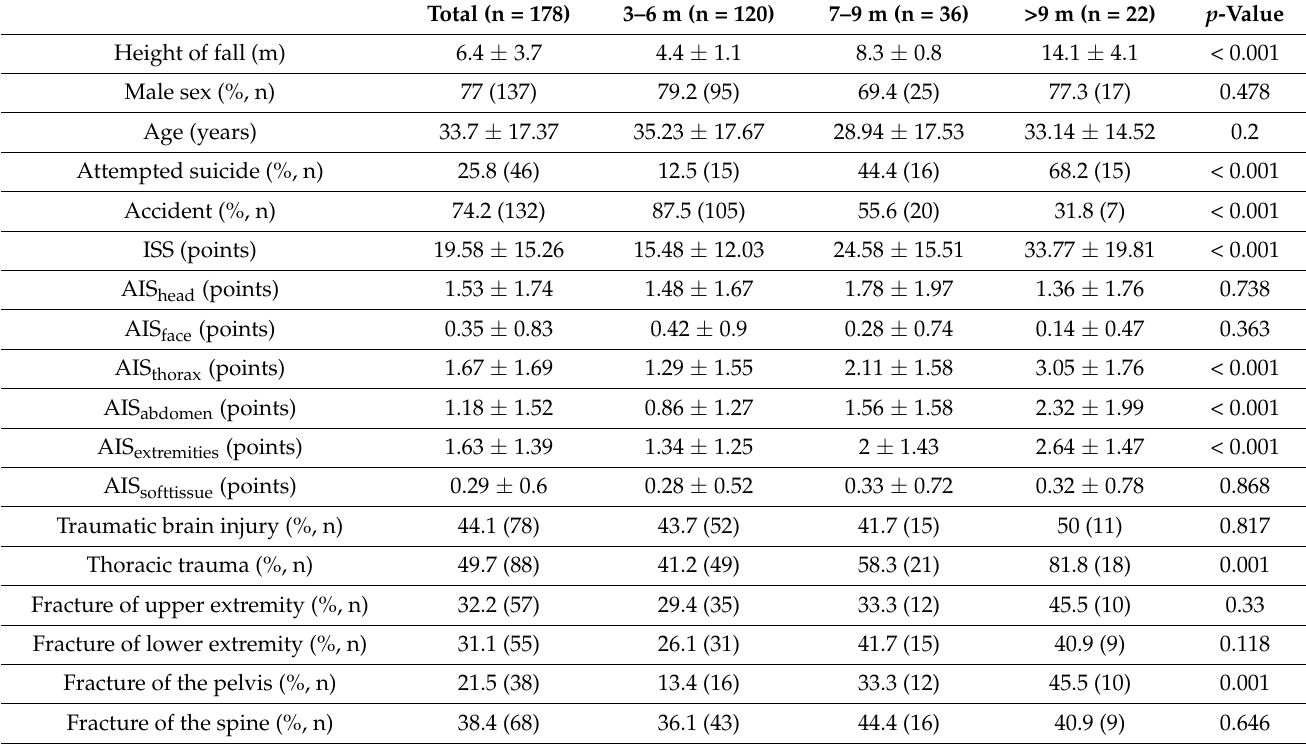
Table 1. Basic patient data in regard to the height of the fall. (ISS: Injury Severity Score, AIS: Abbreviated Injury Scale). Total (n = 178) 3–6 m (n = 120) 7–9 m (n = 36) >9 m (n = 22) p